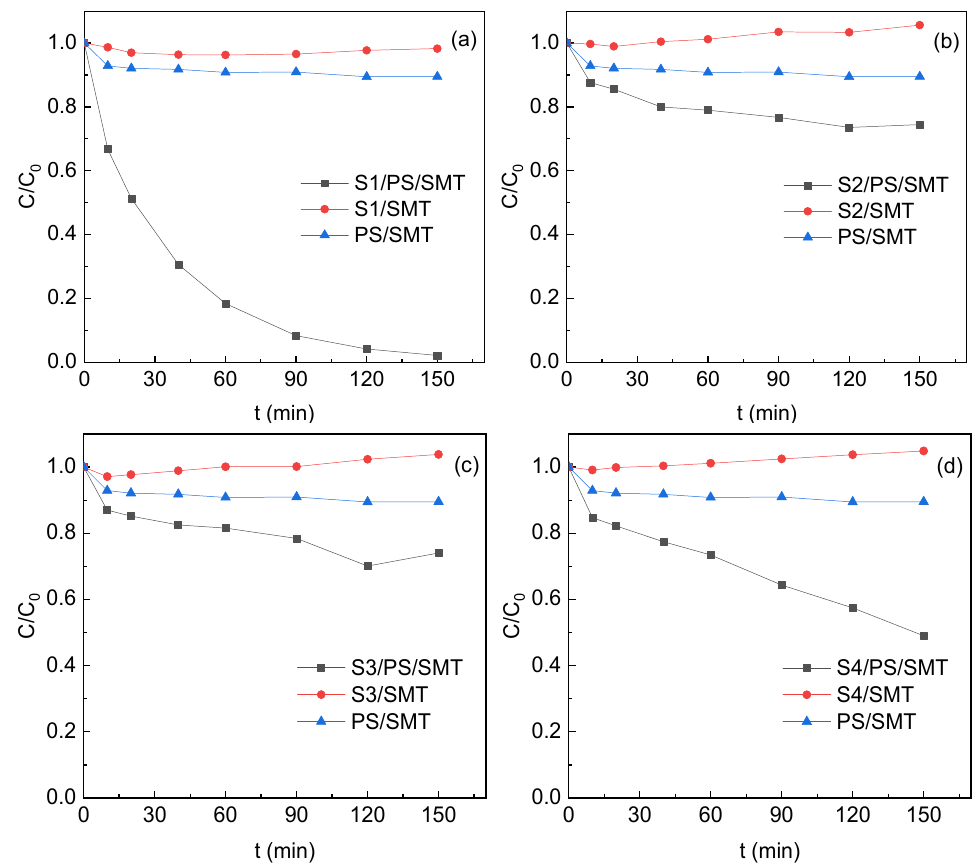
Figure 5. SMT degradation in PS activation by ( a ) S1, ( b ) S2, ( c ) S3 and ( d ) S4. Reaction conditions: [SMT] 0 = 5 mg/L, [PS] 0 = 4 mM, [TM] 0 = 5 g/L, pH 0 = 5 and T = 25 °C. ( a ) was drawn with modification after Zhang et al. [8].